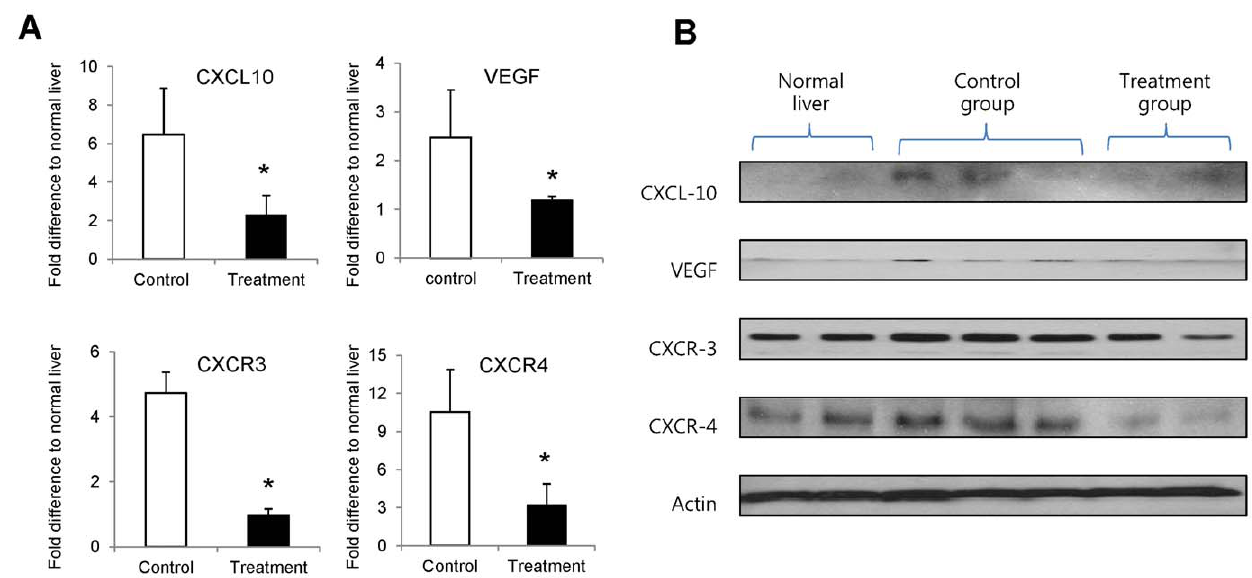
Figure 5. Hepatic gene and protein expressions at 6 hours after hepatectomy and hepatic I/R injury. (A) Hepatic mRNA expressions by real time RT-PCR in different groups. (B) Hepatic protein expressions by Western blot. *P ,